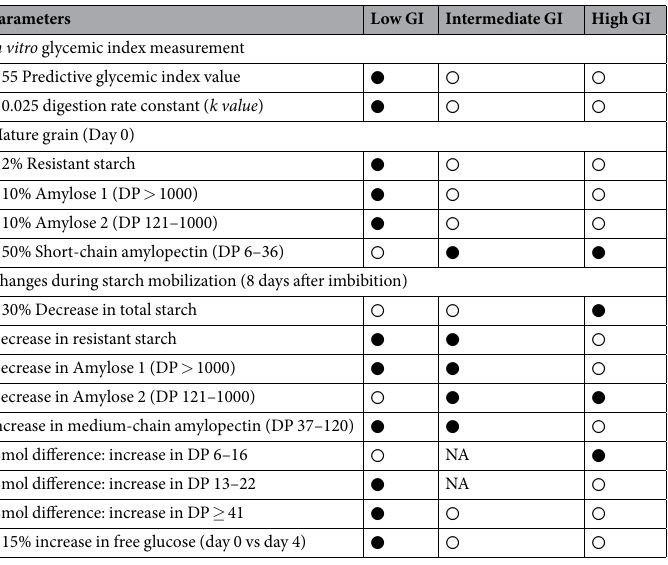
Table 1. Summary of differentiating parameters for the three GI categories. Positive results are marked with ( ● ) and negative results with ( ○